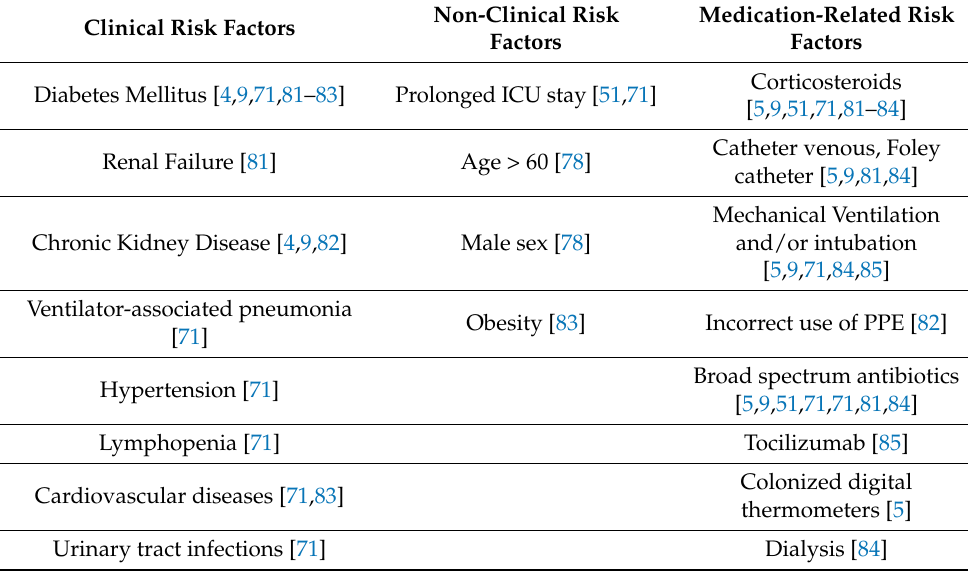
Table 4. Risk factors of C. auris in COVID-19